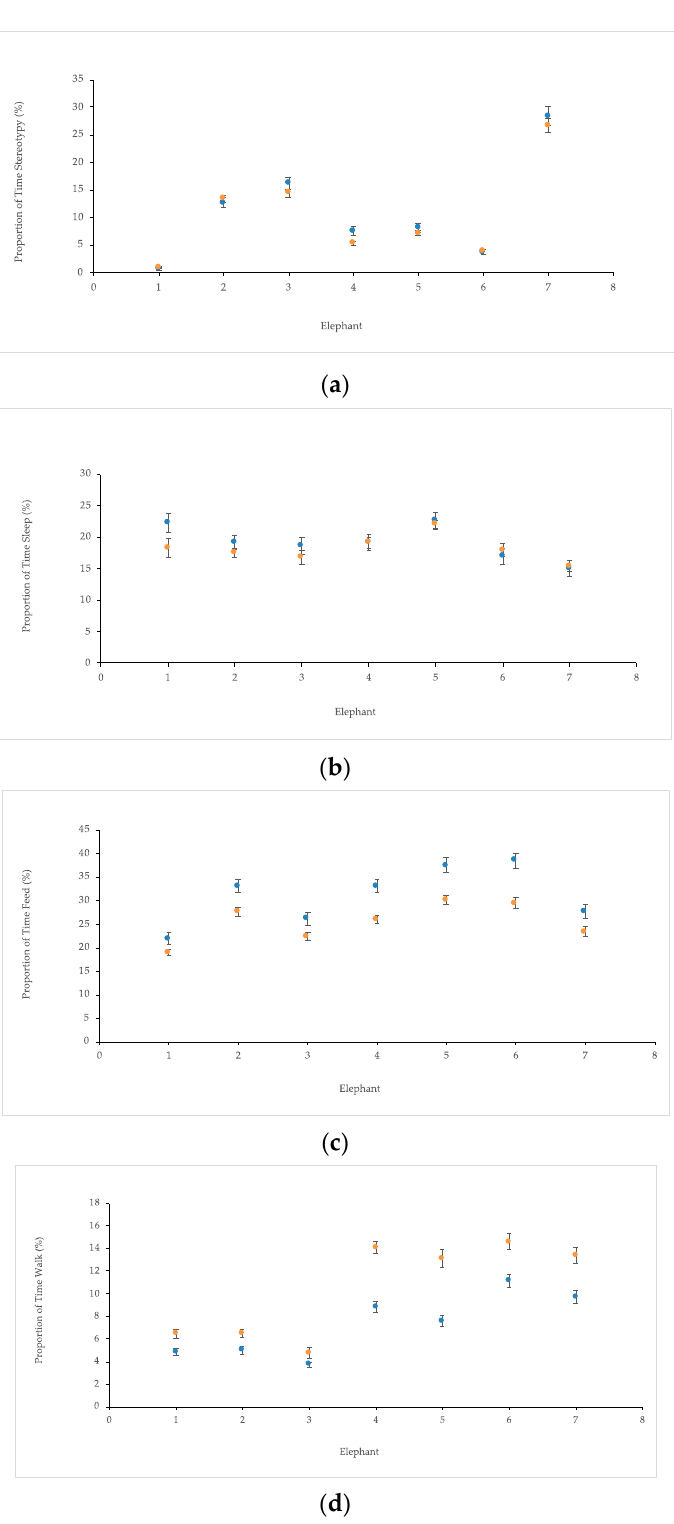
Figure 3. Mean (% ± standard error) proportion of time that combined behaviors ( a ) “Stereotypy” and ( b ) Sleep were observed in 1.6 Asian elephants using both 30 min focal (blue) or 24 h interval (orange) observation methods. Although ( c ) “Feed” and ( d ) “Walk” did vary, similar patterns between elephants still emerged to reveal consistent individual di ff